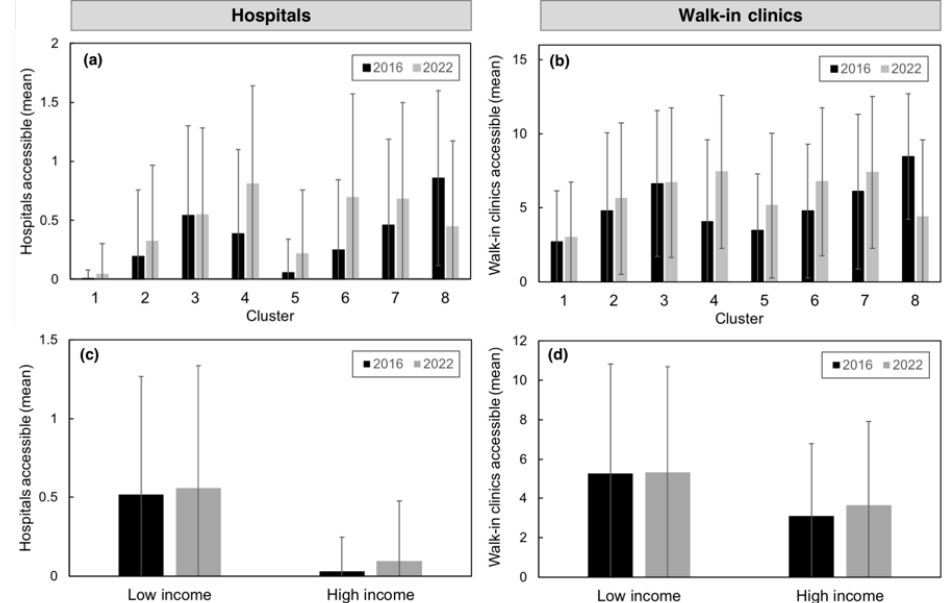
Figure 4. Mean number of ( a ) hospitals and ( b ) walk-in clinics accessible from each cluster’s grid cells, and mean number of ( c ) hospitals and ( d ) walk-in clinics accessible from low- and high-income cluster groupings. Error bars show standard